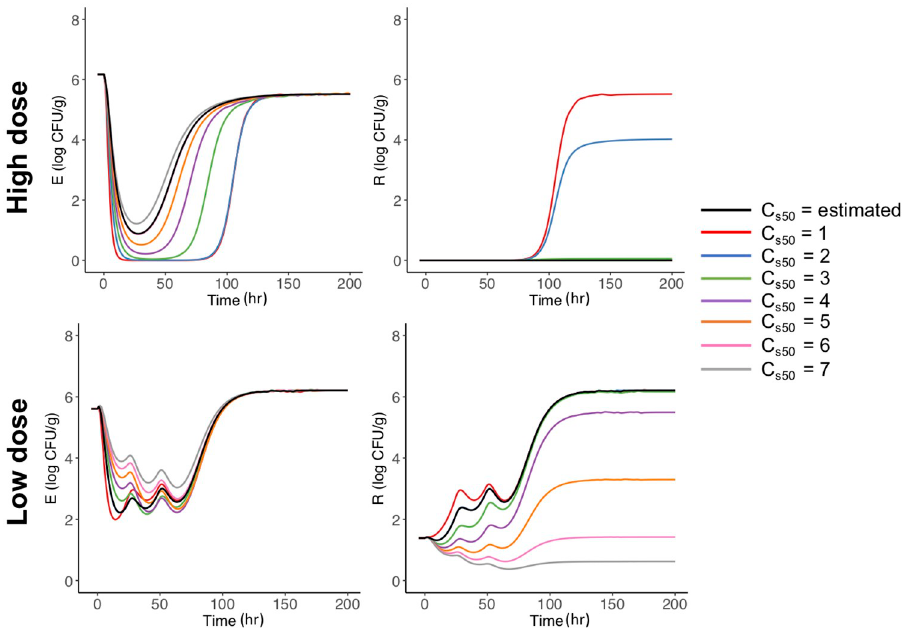
Fig 8. Variations in C s 50 . Simulation of variations of C s 50 and the effects on the high (top row) and low (bottom row) dose model (1). In the simulation C s 50 is varied from the initial estimate of 6.05 or 2.02 (black line) for the high and low dose model, respectively. We vary C with incremental values of 7 (red line), 6 (blue line), 5 (green line), 4 (purple s 50 line), 3 (orange line), 2 (pink line) and 1 (grey line).